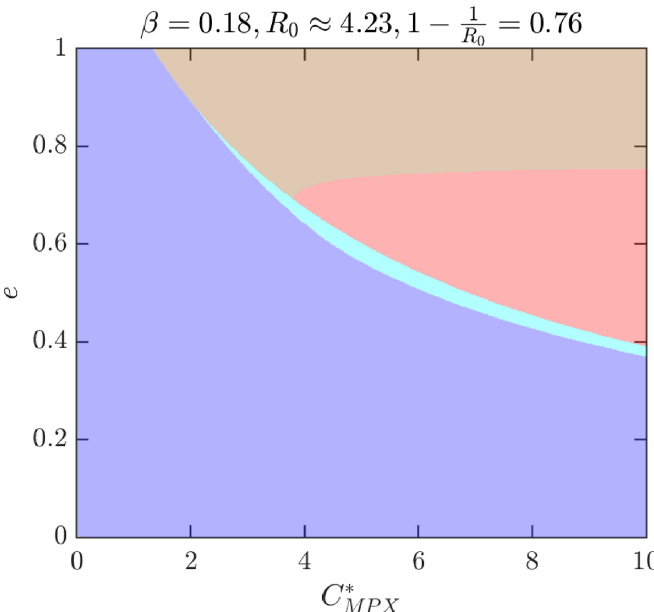
Fig 10. Nash equilibria as e and C � vary for higher transmission rate, β = 0.18. Other parameters are as in Table 1 MPX unless they vary or are otherwise specified. Blue: 0 is the only NE and it is CSNE. Brown: positive ψ NE < ψ max is the only NE and it is CSNE. Light blue: three NEs, 0 and the larger NE are CSNE. Red: maximal feasible vaccination rate is the only CSNE.